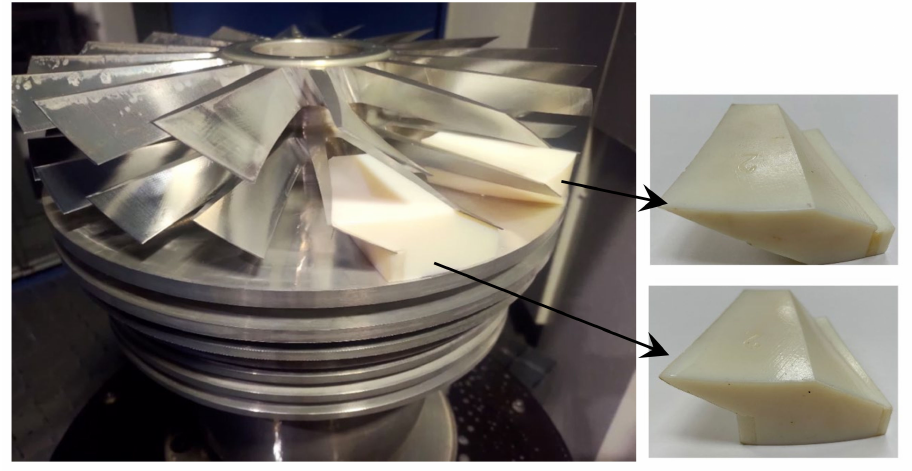
Figure 12. Jig machining